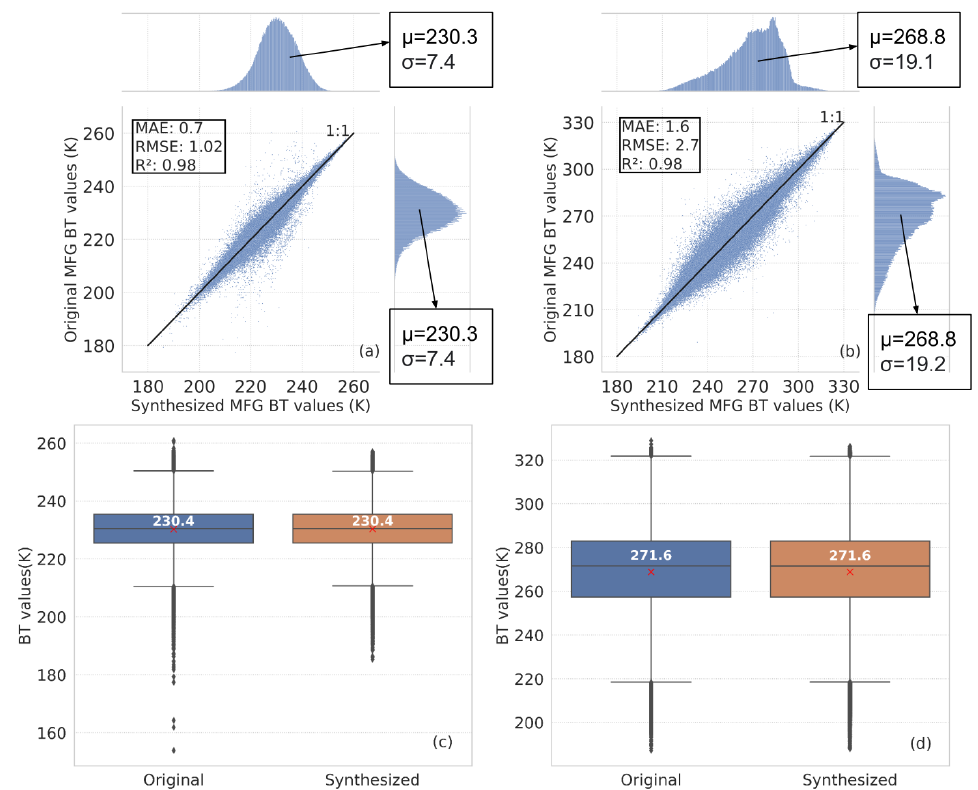
Figure 10. Evaluation of synthesized datasets—( a , b ): Scatterplots depicting relationship between the synthesized and original values for WV and IR channel, respectively. The black lines in both the plots are 1:1 reference line. ( c , d ): Boxplots showing the distribution of the original and synthesized values for WV and IR channel,